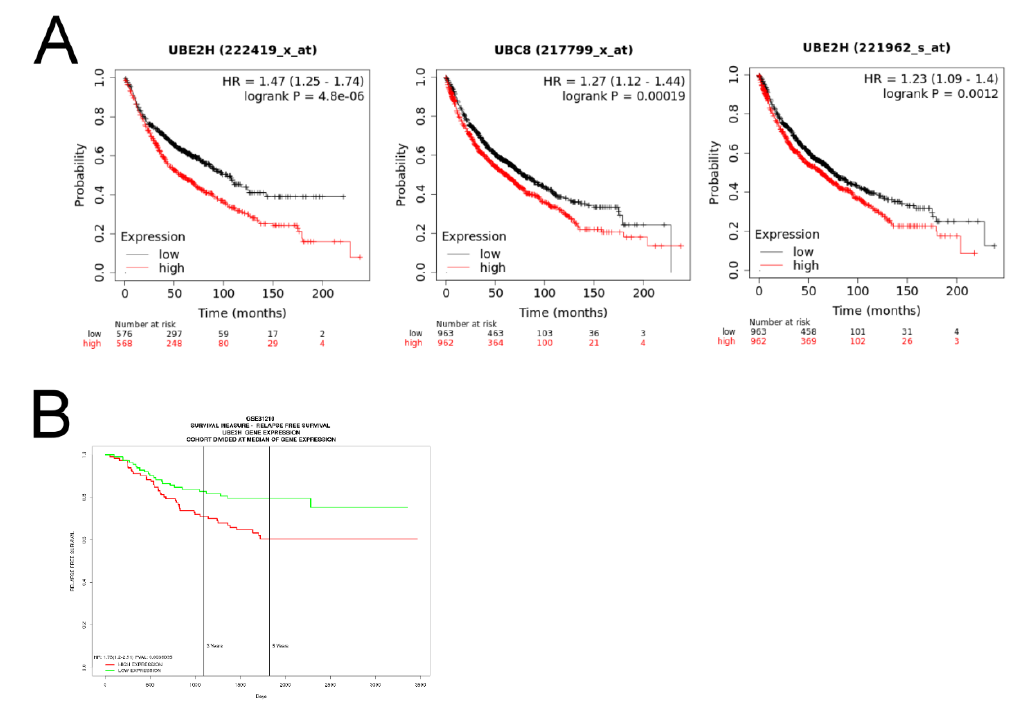
Figure 2. The correlation of UBE2H expression and survival in patients with LUAD. ( A ) The survival analysis via the KM plotter. The samples are divided into high and low expressions according to median expression value of UBE2H. The red and black lines indicate high and low UBE2H expressions, respectively. Three plots are analyzed by the different probes labeled on each plot. ( B ) The survival analysis via GSE31210 dataset on SurvExpress. The red and green lines indicate high and low UBE2H expressions, respectively. HR—hazard ratios.